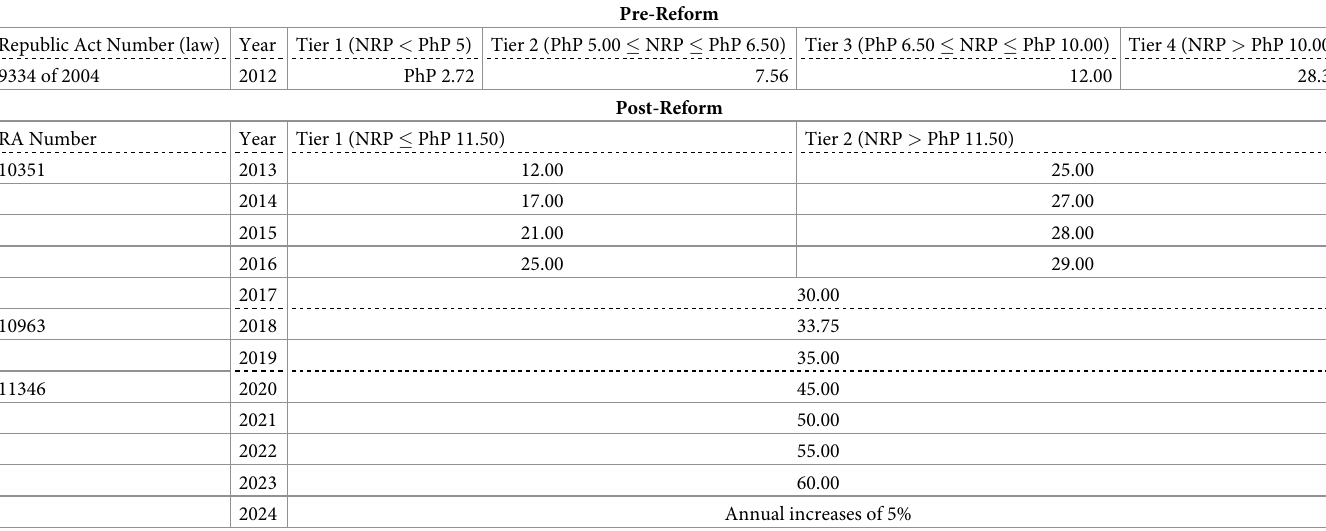
Table 1. Pre- and post- 2012 reform excise tax amounts in Philippine peso